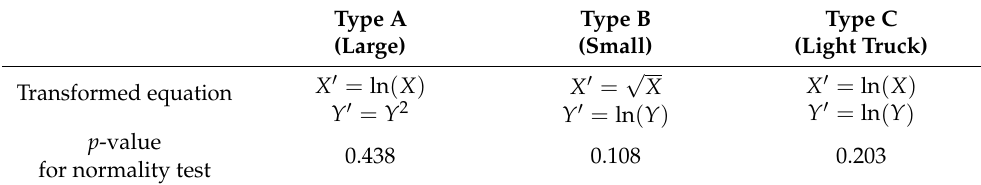
Table 2. Best transformation models and the normality